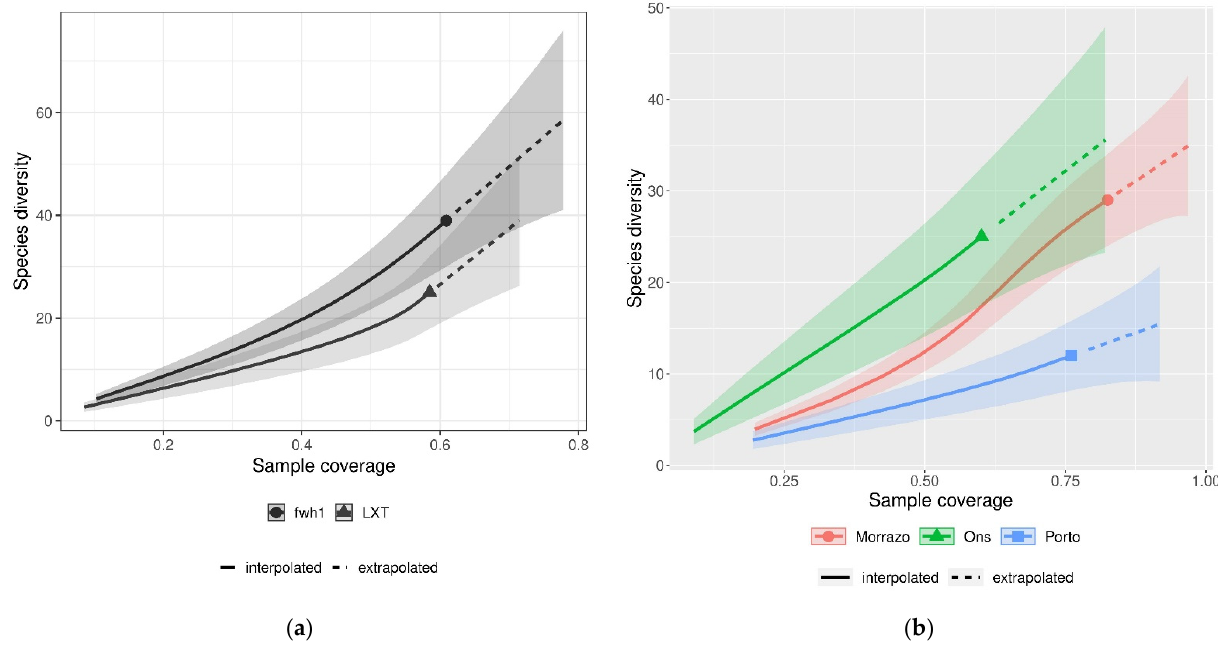
Figure 2. Species diversity extrapolated as a factor of sample coverage for ( a ) different CO1 fragments; ( b ) sampling regions. Points indicate the observed richness, while error bars indicate the 95% confidence intervals of the response curves.